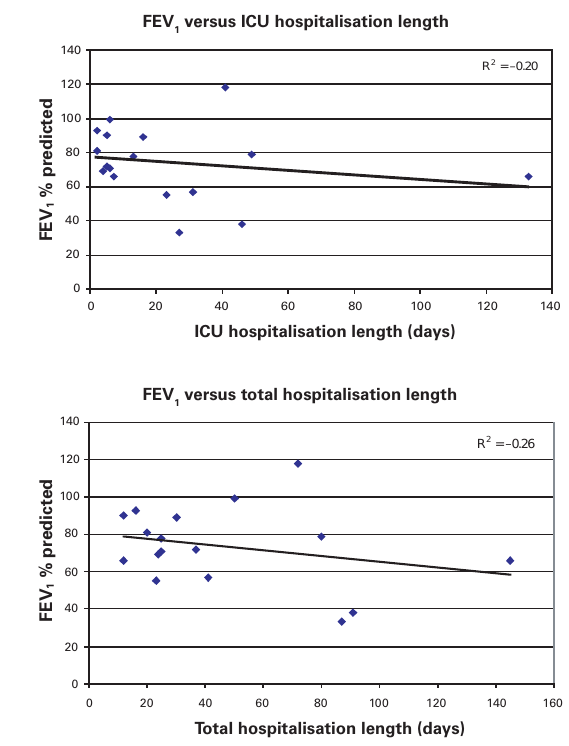
Figure 3 FEV 1 versus ICU hospitalisation length and total hospitalisation